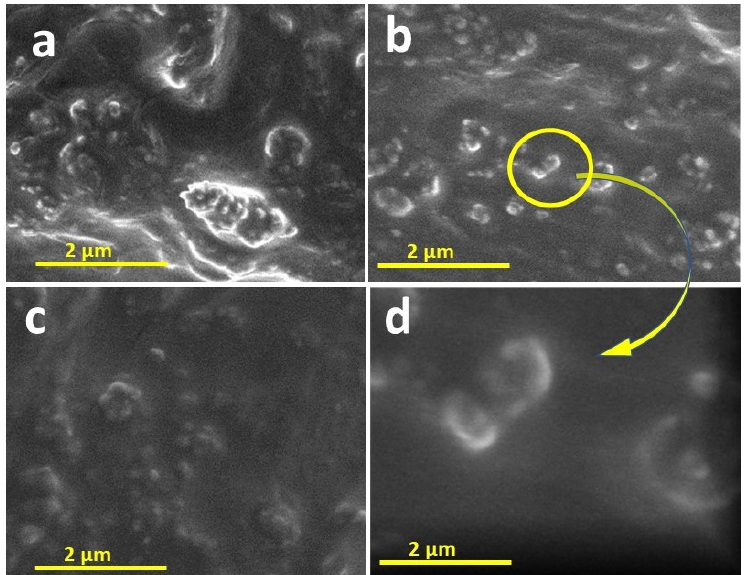
Figure 2. SEM images at higher magnification for ( a ) Unwashed fabric, after ( b ) 10 washing cycles, ( c ) 20 washing cycles, ( d ) higher magnification of ( b ).